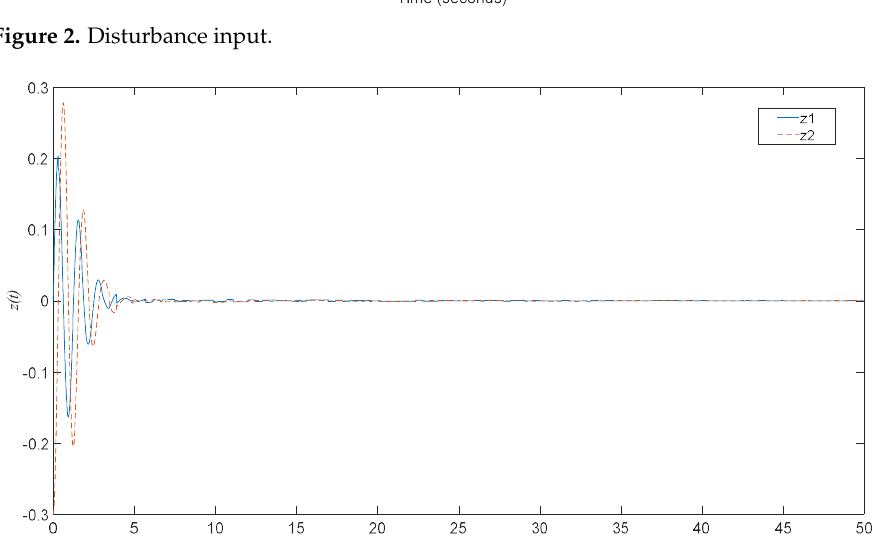
Figure 3. Output of system (1) for the synchronous signal in (29) and sampling input in (30).